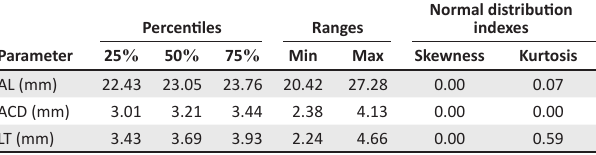
TABLE 2: The percentiles, range, skewness and kurtosis of axial length, anterior chamber depth and lens thickness in this study.